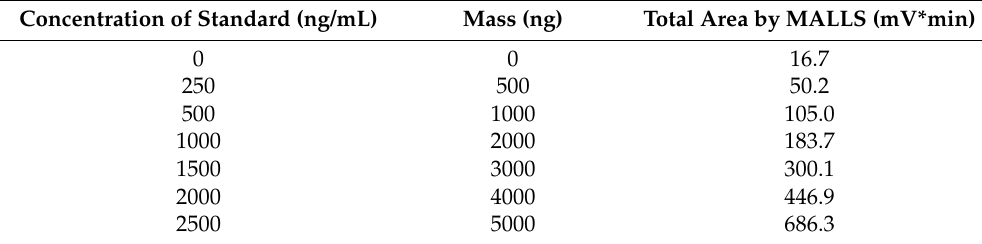
Table 1. Peak areas of Laponite particles obtained by Multi Angle Laser Light Scattering (MALLS) detection (2000 µ L injection volume).